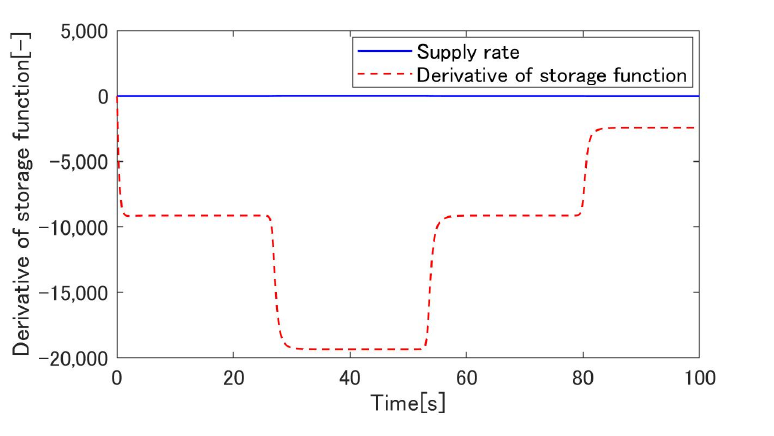
Figure 17. The derivative of the storage function V .